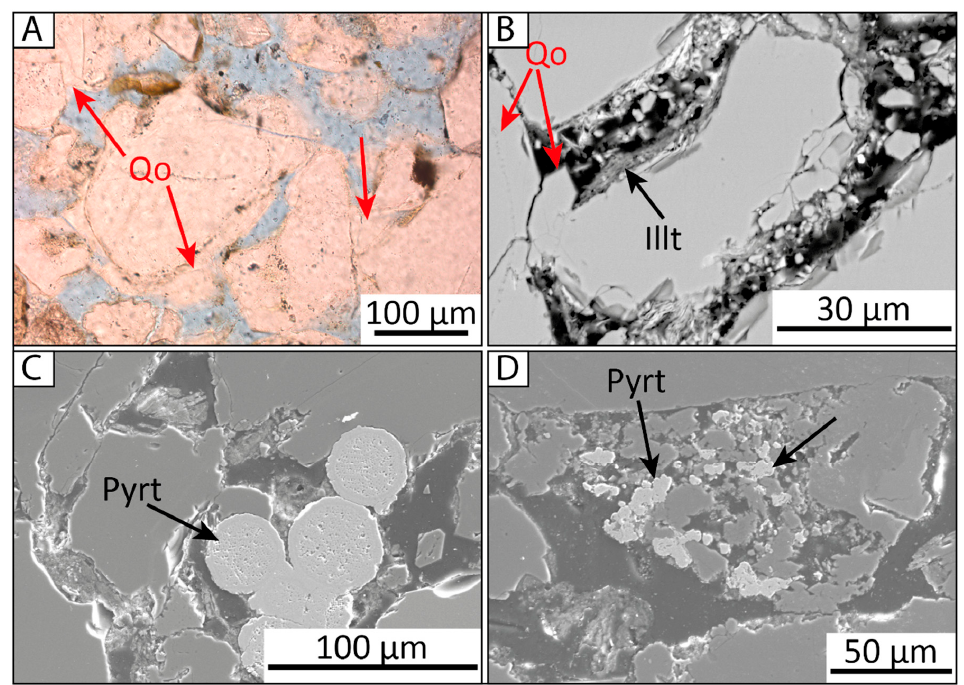
Figure 9. Thin-section, BSE, and SEM images showing the development of quartz overgrowths and the mode of occurrence of pyrite. ( A ) Well development of quartz overgrowths (Qo) due to lack of grain-coating clays. ( B ) Grain-coating illite (Illt) inhibiting the formation of quartz overgrowth (Qo). ( C ) Framboidal pyrite (Pyrt) filling intergranular porosity. ( D ) Formation of grain-replacive pyrite (Pyrt) replacing partly dissolved plagioclase feldspar. [BSE = Backscattered Electron; SEM = Scanning Electron Microscope].